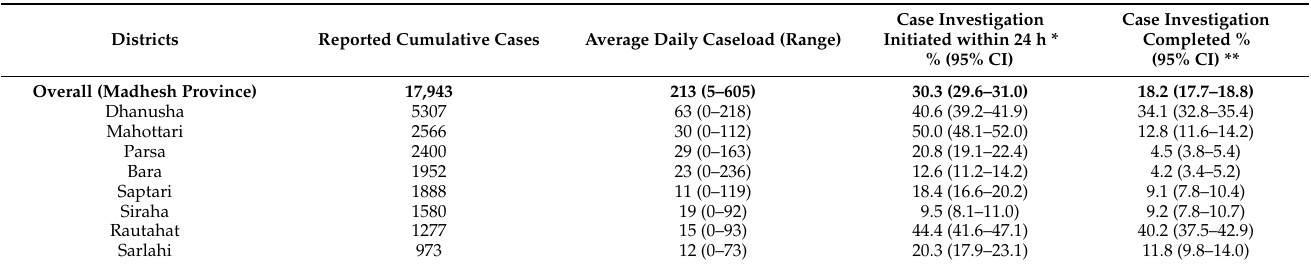
Table 1. District trends in timeliness of initiation and completion of case investigation in the